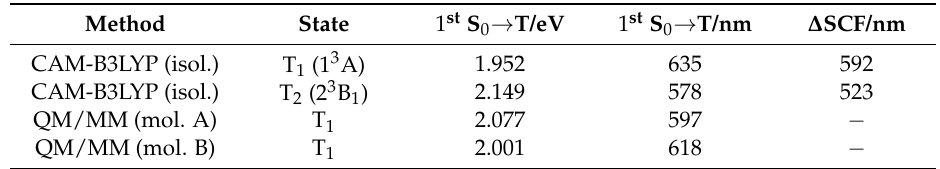
Table 8. The TDDFT-computed excitation energies from the ground state to the first triplet state calculated for the optimised geometries of the S 0 , T 1 , and T 2 states. CAM-B3LYP denotes theoretical isolated-molecule results, and QM/MM denotes modelled solid-state structures; ∆ SCF is the difference between the electronic energy of the triplet state and energy singlet states (both calculated at the triplet minimum-energy